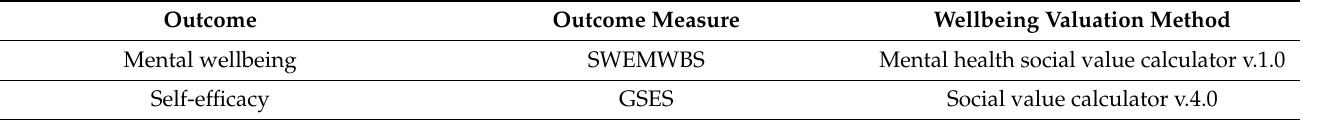
Table 1. Wellbeing valuation